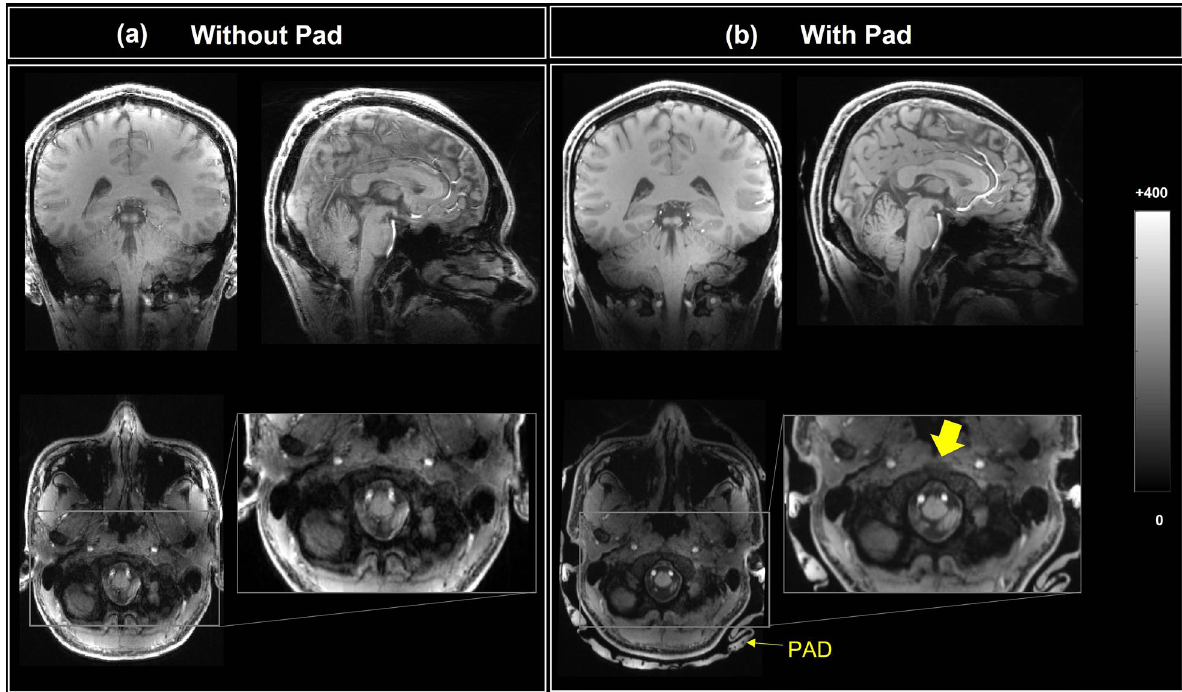
Fig. 2 Images were acquired to investigate any effects of the high‑dielectric pad in T1‑weighted images using 7 T MRI. a and b corresponding images acquired with and without high‑dielectric pads, respectively. Increased tissue contrast and signal intensity are observed in images with pad ( b ) compared to those without pad ( a ). The yellow arrow indicates the representative area of enhanced tissue